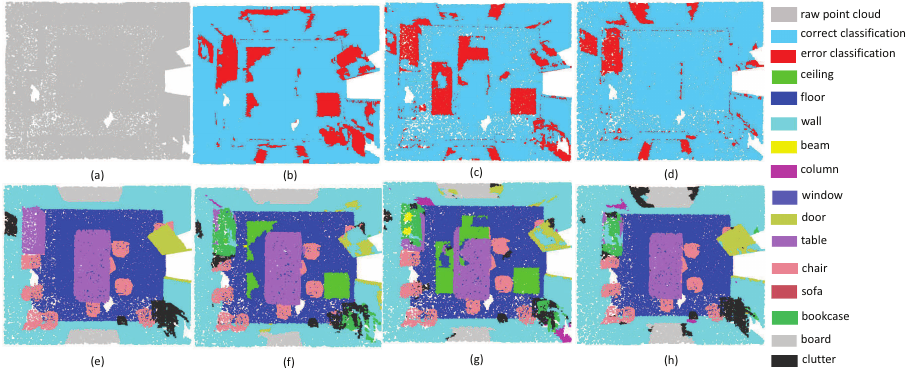
Figure 13. The segmentation results on ConferenceRoomS 3 D . ( a ) input, ( e ) ground truth, ( b , f ) the classification result by PointNet++, ( c , g ) the classification result by PointSIFT, and ( d , h ) the classification result by